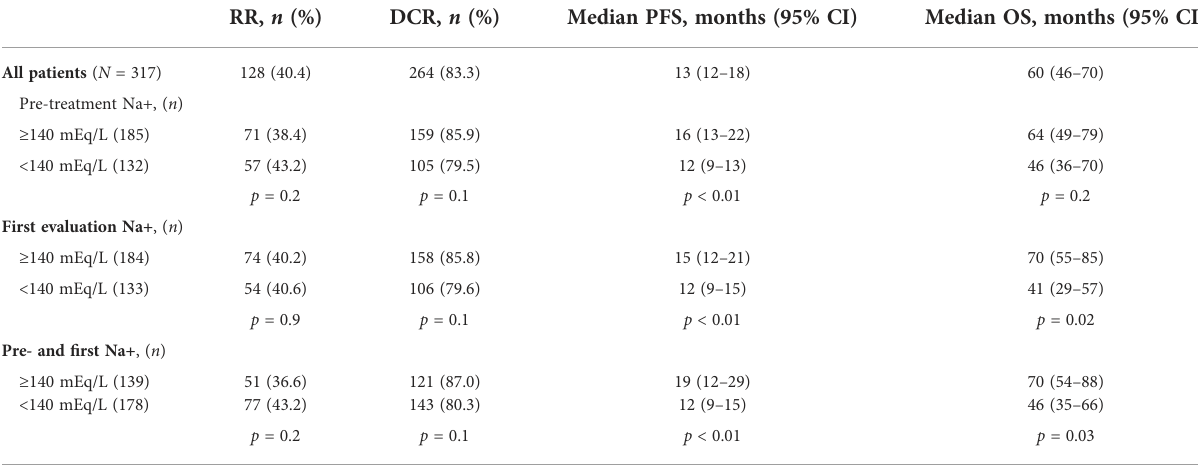
TABLE 2 Best response, PFS, and OS according to serum sodium